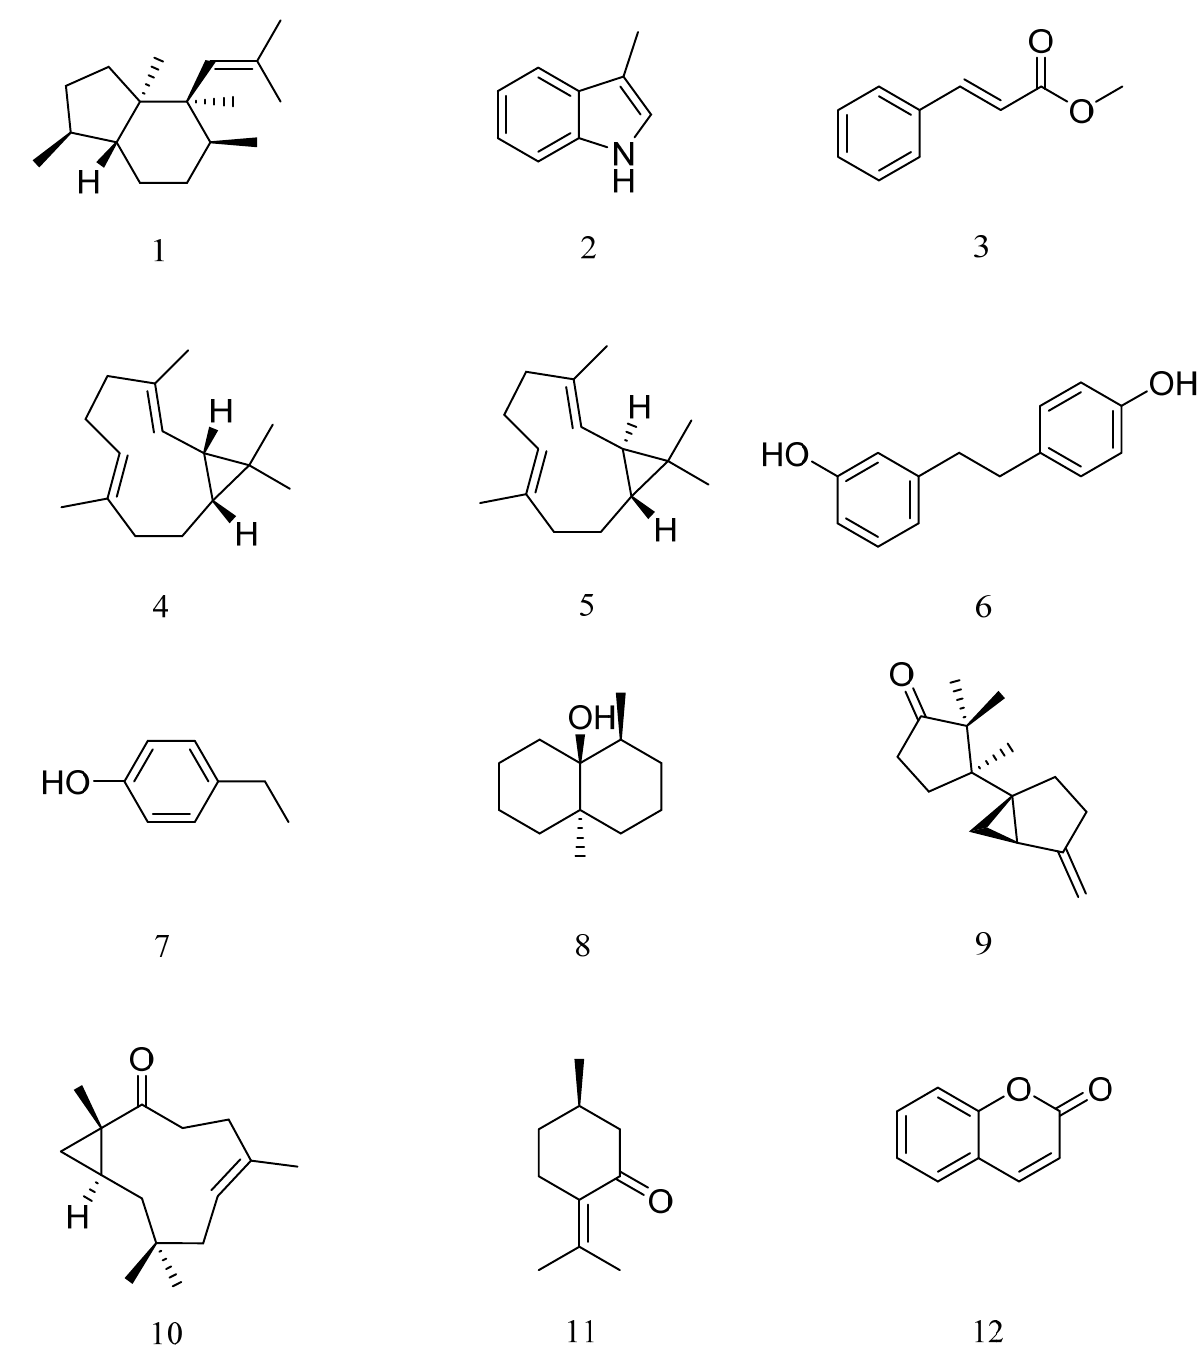
Figure 1. Chemical structures of compounds mentioned in Table 2 ( 1 : tamariscol; 2 : scatole; 3 : methyl cinnamate; 4 : bicyclogermacrene; 5 : isolepidozene; 6 : lunularin; 7 : p-ethylphenol; 8 : geosmin; 9 : grimaldone; 10 : bicyclohumulenone; 11 : R-pulegone; 12 : coumarin).